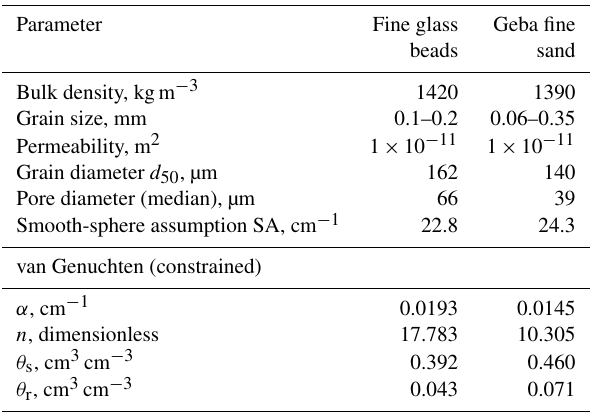
Table 1. Characteristic properties of the porous media used for the